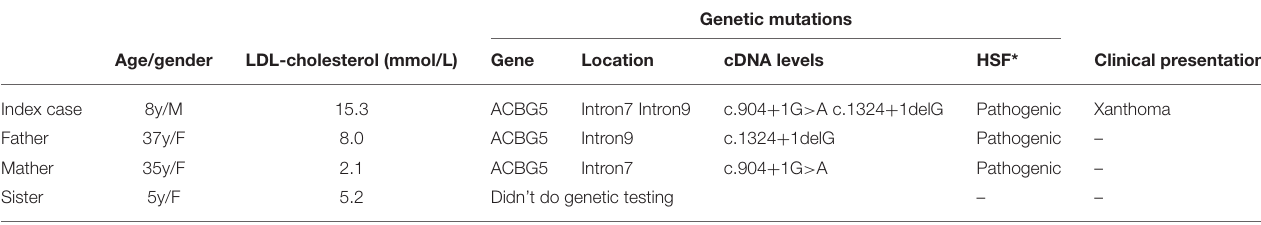
TABLE 1 | Serum LDL-cholesterol level, gene mutation and clinical manifestation of the family.